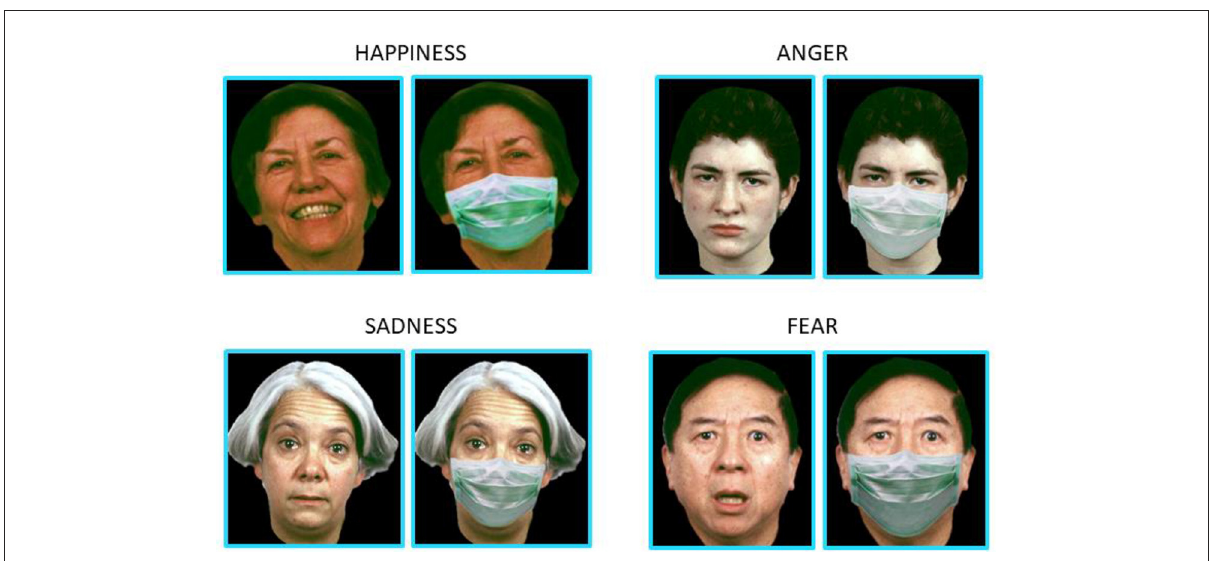
FIGURE1 Examples of low-intensity facial configuration with and without face masks for happiness, anger, sadness, and fear. Face images were obtained with permission from the ER-40 color emotional stimuli public database (30, 31).